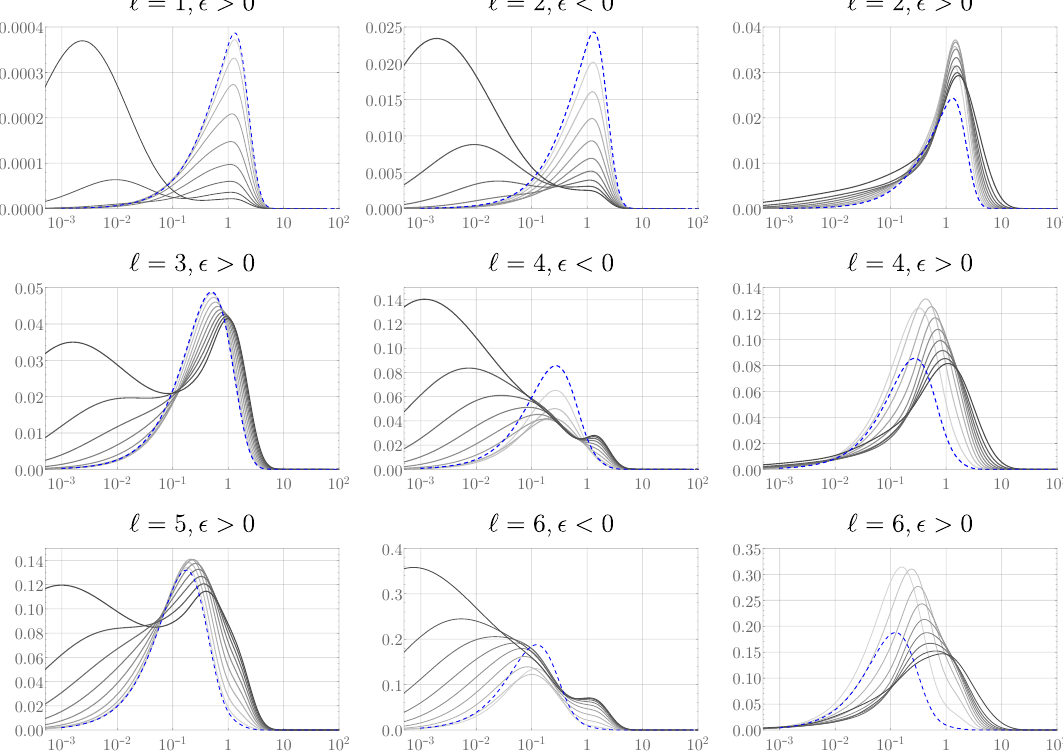
Figure 3. The differenced heat kernel ∆ K L ( t ) as a function of t for the minimally-coupled scalar on the deformed spheres given by (4.9). Each plot shows the rescaled heat kernel − σ ∆ K L /(cid:15) 2 (except for ‘ = 1 , which shows − σ ∆ K L /(cid:15) 4 ), with the dashed blue line corresponding to the perturbative result (3.15) and the gray lines to the numerical results for the deformations shown in figure 2 (hence light to dark gray corresponds to increasing | (cid:15) | , with (cid:15) ∈ [0 . 9 (cid:15) min , 0 . 9 (cid:15) max ]